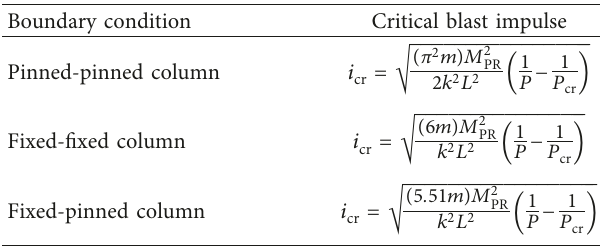
Figure 25: Column deformation shape used in analytical model. (a) Elastic phase. (b) Plastic phase. Table 5: Equations for the critical blast